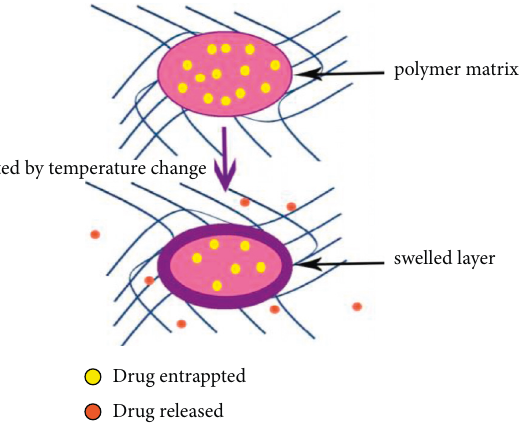
Figure 5: Electrospun thermo-sensitive nanofibers drug release profile